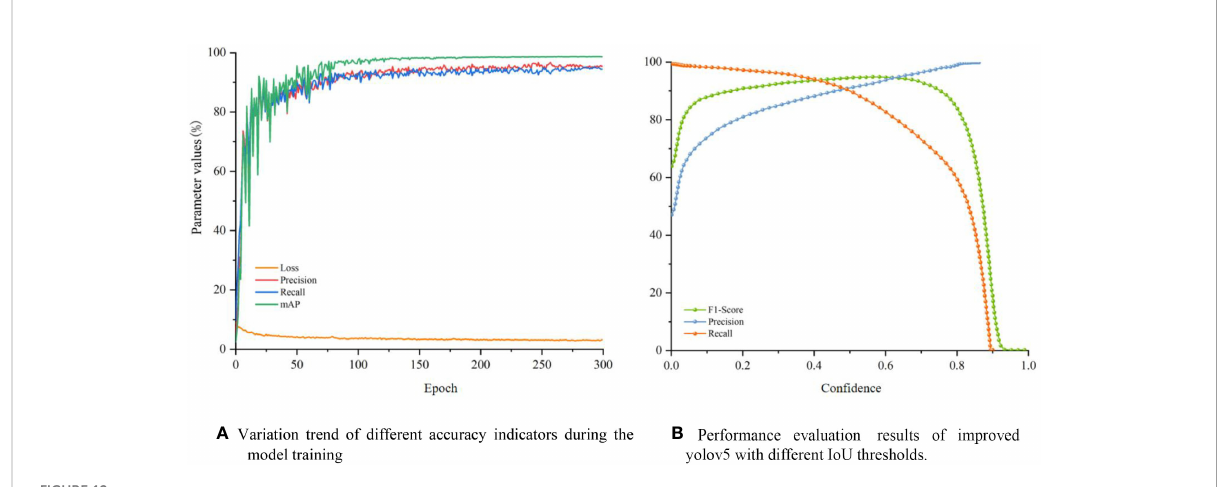
TABLE 2 Results of ablation experiment.